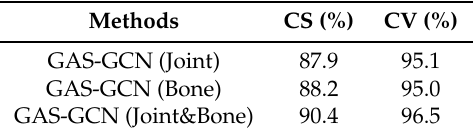
Table 4. Two-stream fusion results on NTU-RGB + D dataset.